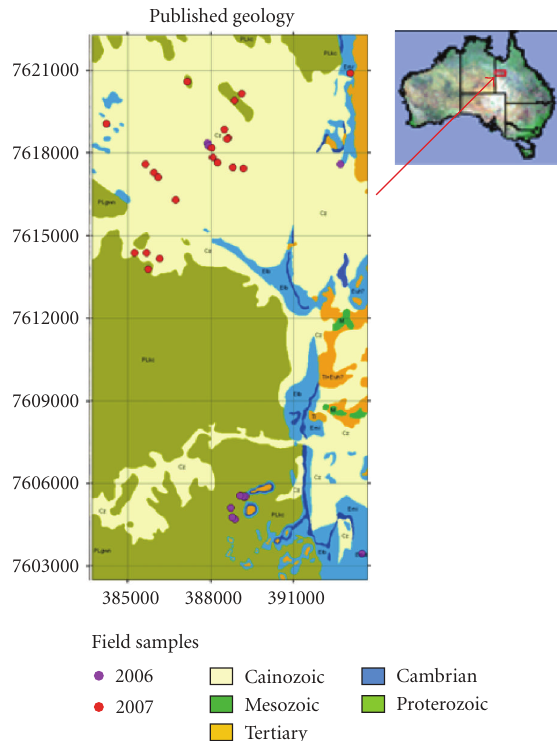
Figure 2: Location of the Tick Hill study area [24], North Queen- sland, Australia.